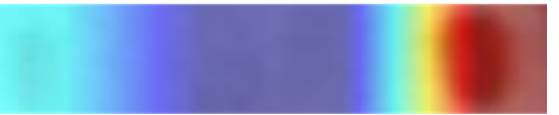
Figure 2. Score-CAM heat map on Hb electrophoresis test image.